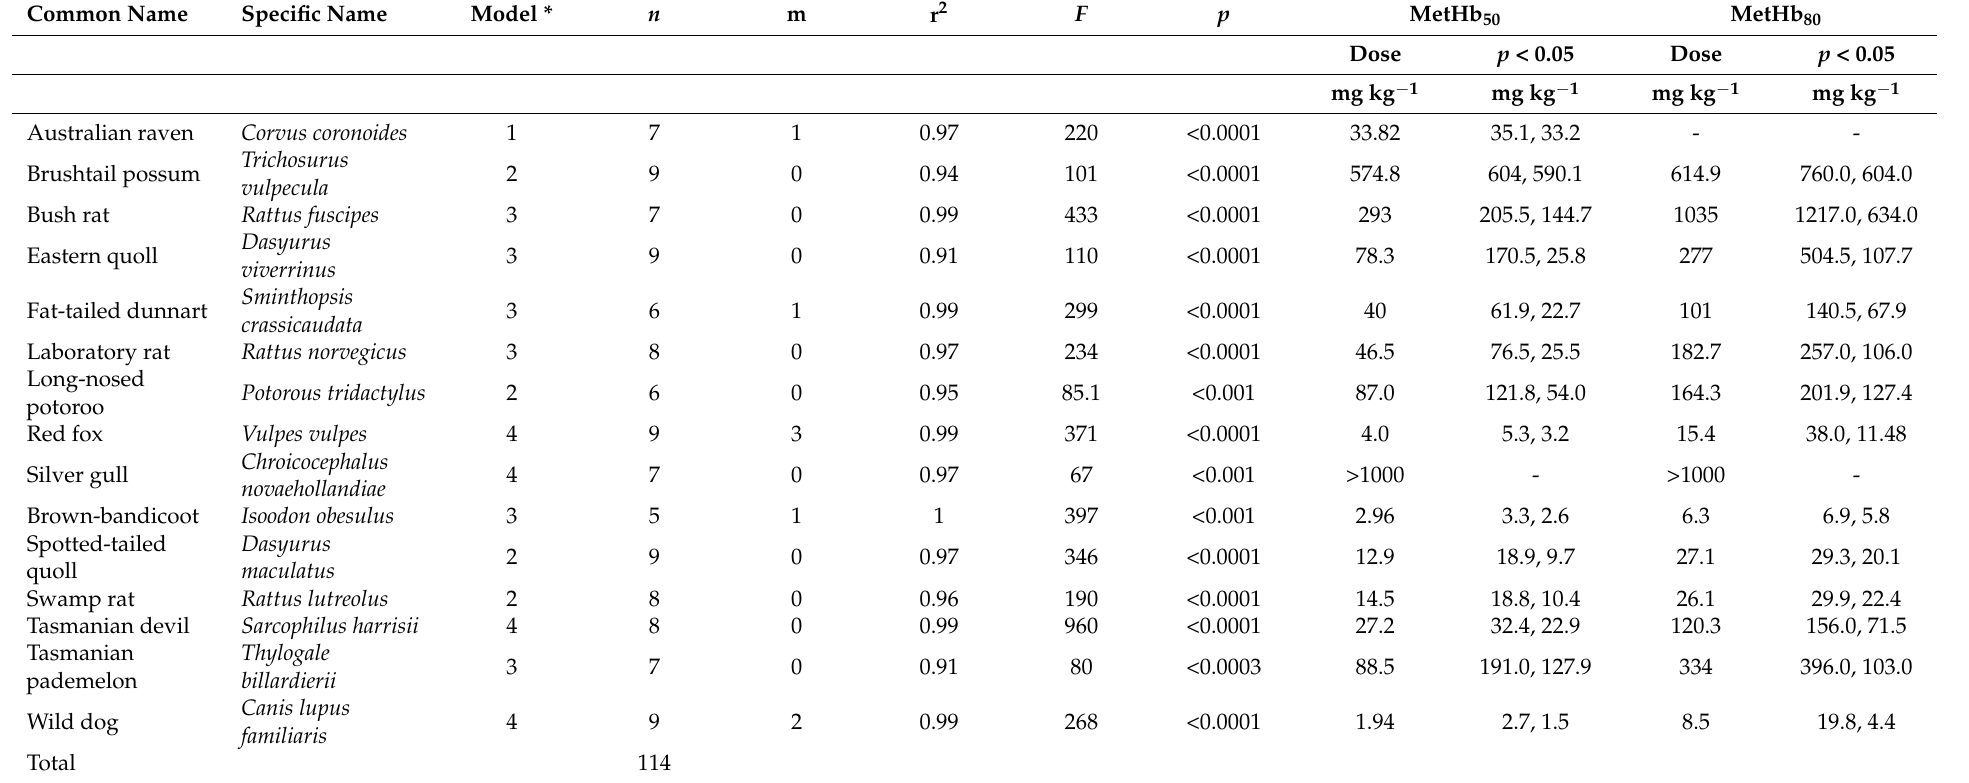
Table 1. Oral PAPP dose in mg kg − 1 formulated with DMSO estimated to produce 50% (MetHb 50 ) and 80% (MetHb 80 ) MetHb based upon fitted models with upper and lower prediction estimates ( p <